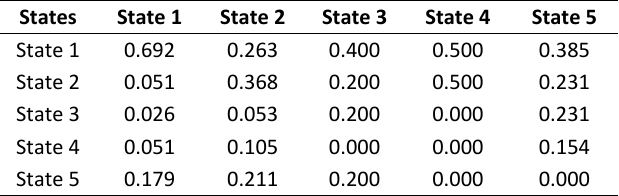
Table 4. Transition probabilities of normal progress group .